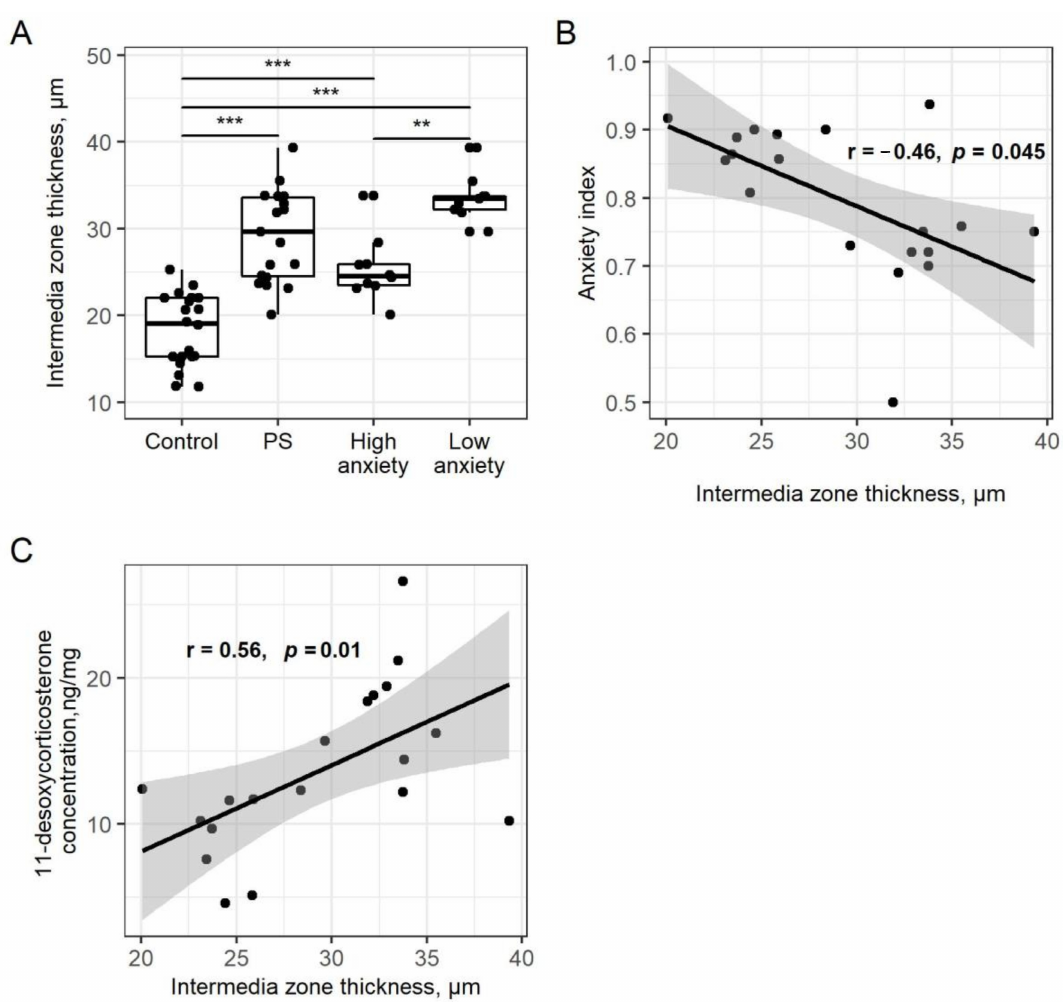
Figure 6. Panel ( A ). Adrenal zona intermedia thickness is increased after PSS . Zona intermedia thickness of control, PSS, high- and low-anxiety groups. Differences in adrenal cortex thickness values among groups are shown as boxplots with dots rep-resenting individual data values and medians shown by horizontal lines. The boxes include the central 50% of the data, i.e., from the 25th to the 75th percentile. The whiskers include the data contained within 1.5 times the interquartile range. NS = p > 0.05; ** p < 0.01; *** p < 0.001. p values determined in parametric analysis. Panel ( B ). Correlation between AI values and zona intermedia thickness in the PSS group (r = − 0.46, p < 0.045). The gray area around the line represents the 95% confidence interval. Panel ( C ). Correlation between adrenal 11-desoxyCORT concentration and zona intermedia thickness in the PSS group (r = − 0.56, p = 0.01). The gray area around the line represents the 95% confidence